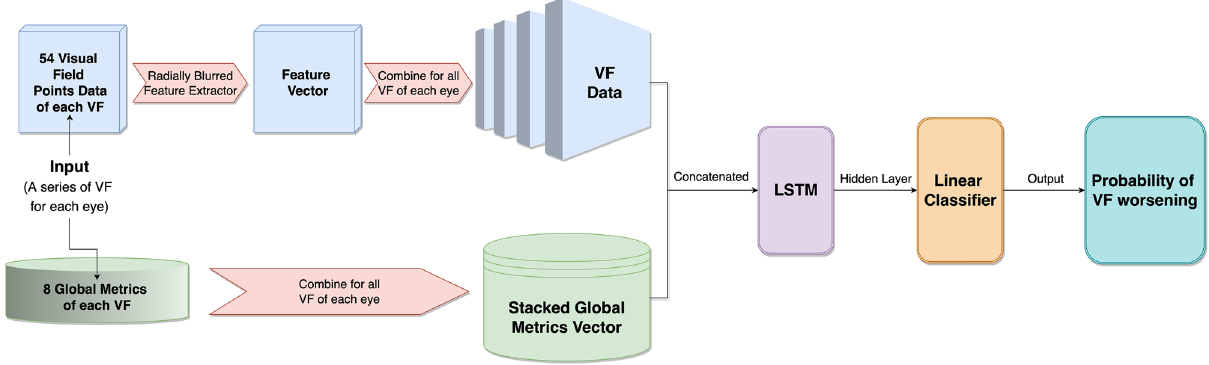
Figure 3. Deep learning model diagram. Deep learning architecture that incorporates data from visual fields and their 8 global